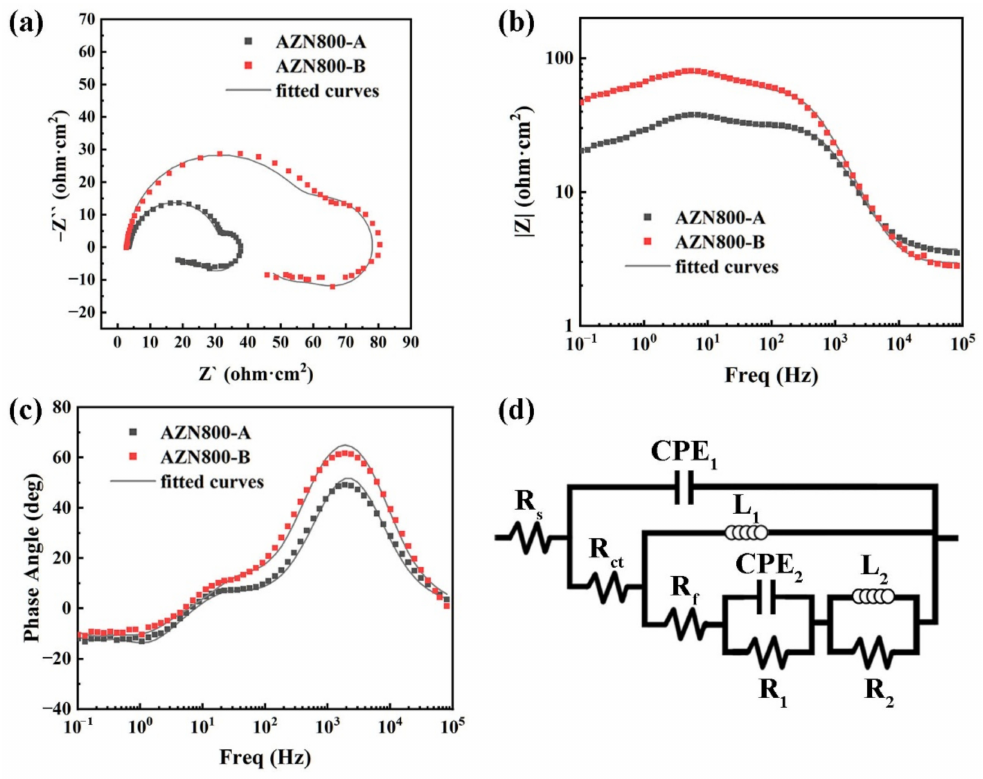
Figure 8. EIS of the AZN800-A and AZN800-B alloys after immersion in 3 wt.% KCl solution: ( a ) Nyquist plots curves, ( b ) Bode plots curves, ( c ) phase angle plots, ( d ) equivalent circuits.